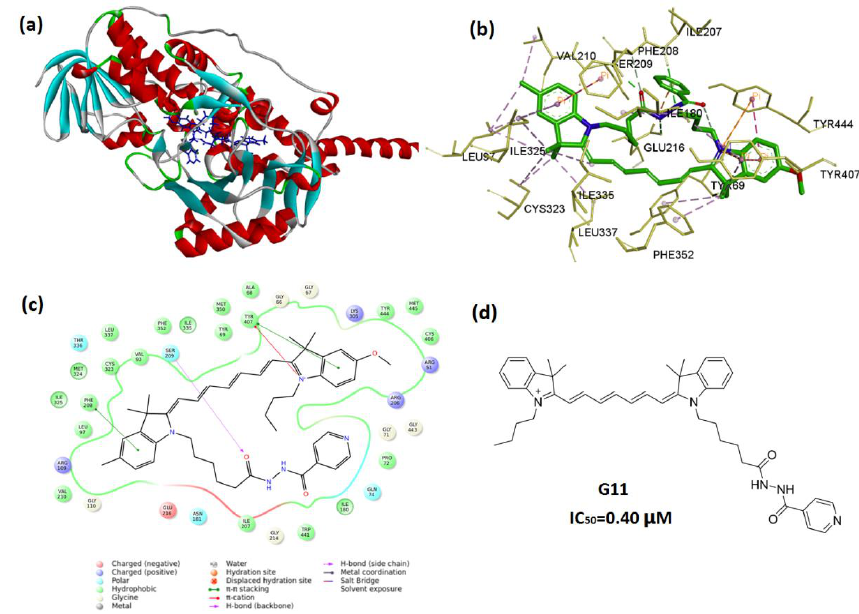
Figure 2. Molecular docking model of compound G11 interacting with the active site of 2BXR . ( a ) The docking site of G11 (blue) in 2BXR . ( b ) 3D ligand interactions diagram. ( c ) 2D ligand interactions diagram. ( d ) The structure of G11.